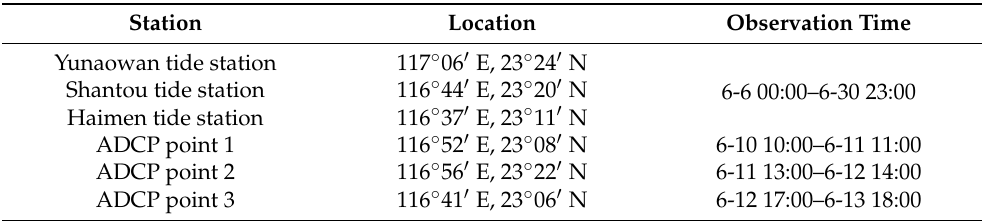
Table 2. Information of tide stations and ADCP points.